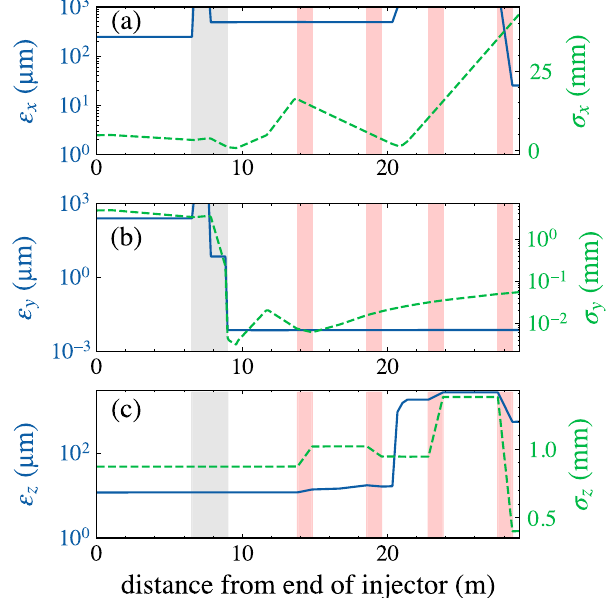
FIG. 4. Evolution of the horizontal (a), vertical (b), and longitudinal (c) emittance (blue traces) and bunch size (green dashed traces) along the emittance manipulation beamline (com- bining the RFBT and EEX transformations). The vertical shaded bands indicate the locations for the RFBT ’ s skew-quadrupole magnets (gray band at distances < 10 m are for SQ1-3) and dipole magnets (red bands from ∼ 14 m to the end of the beamline are for B1-4) associated with the EEX beamline; see Fig.